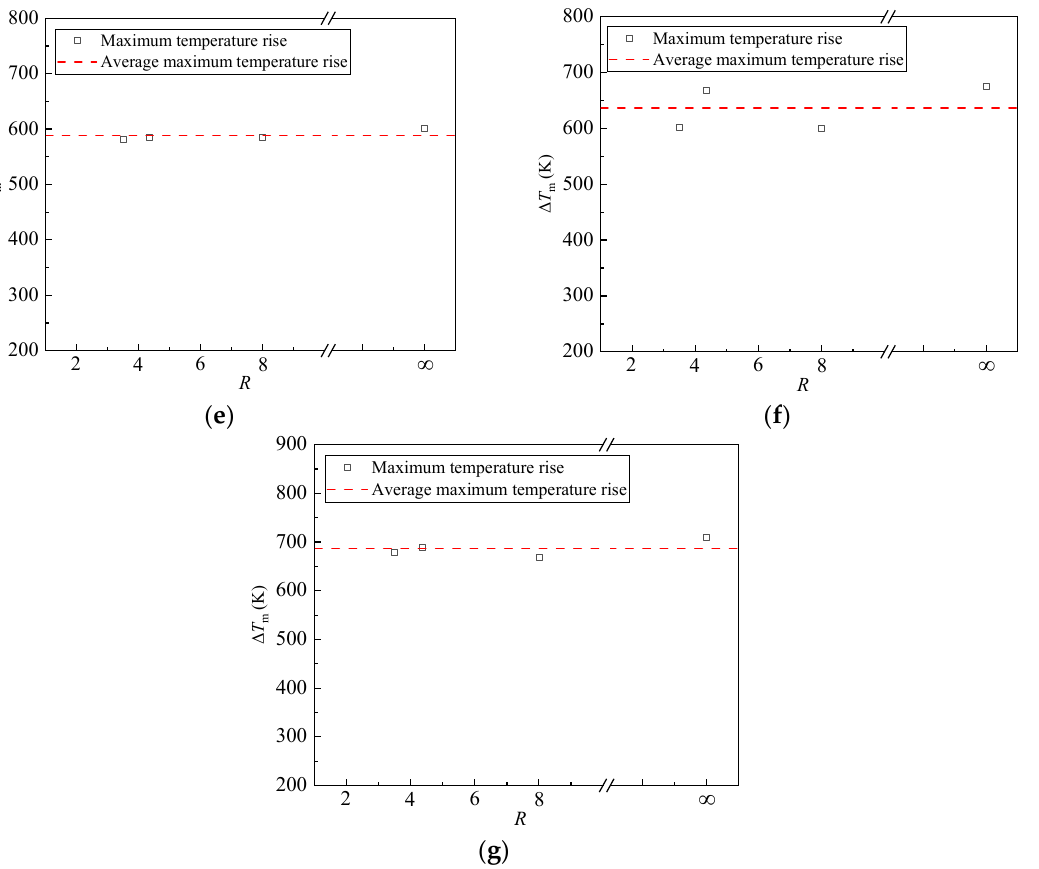
Figure 4. Measured value of maximum temperature rise ( ∆ T m ) against the tunnel turning radius: ( a ) Q = 0.76 kW; ( b ) Q = 1.01 kW; ( c ) Q = 1.62 kW; ( d ) Q = 2.03 kW; ( e ) Q = 2.43 kW; ( f ) Q = 3.05 kW; ( g ) Q = 4.06 kW.